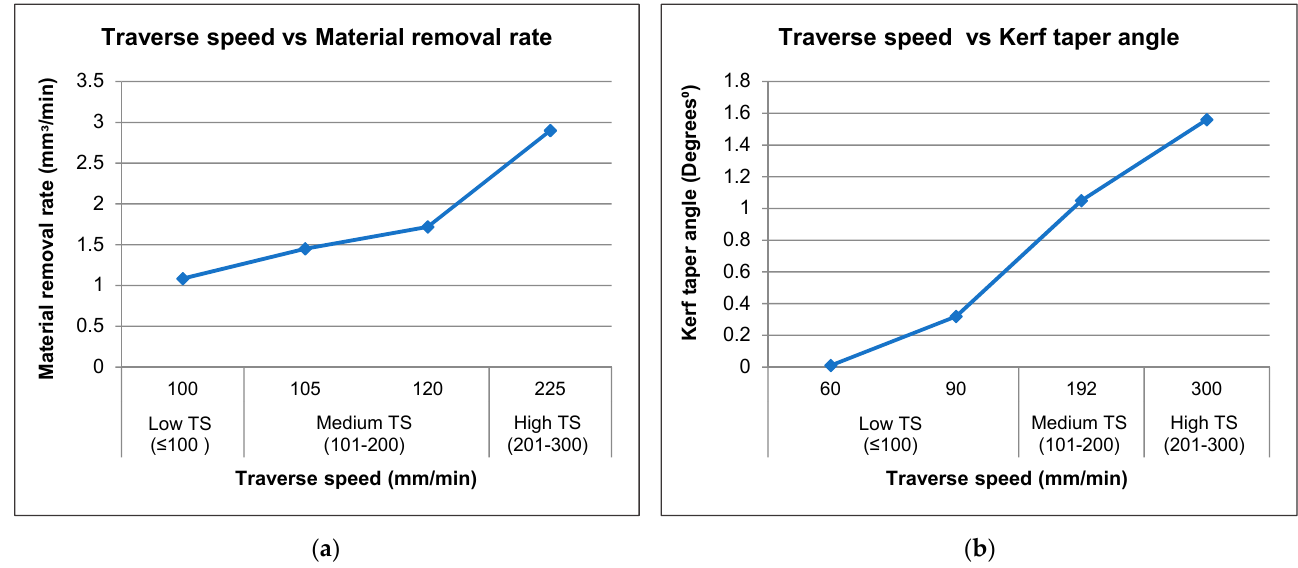
Figure 1. Statistics of impacts of traverse speed in ( a ) Material removal rate and ( b ) Kerf taper angle AWJ straight line cutting of various metals [8,15,18–22] .